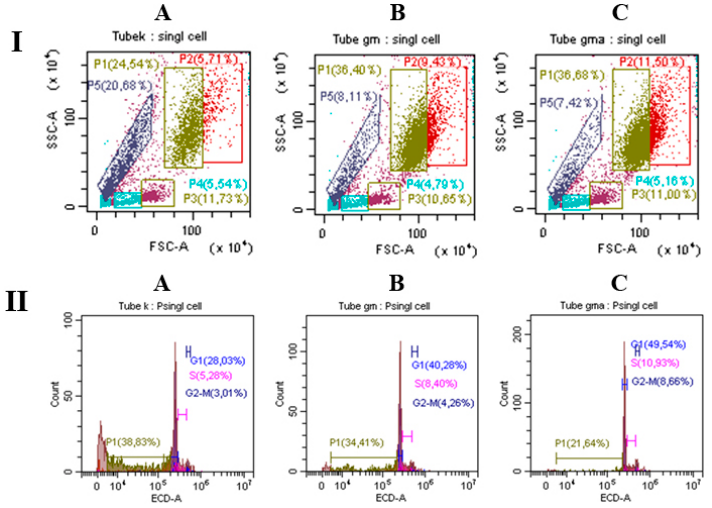
Figure 6. Flow cytometric analysis ( I ) and cell cycle of all BMCs ( II ) treated of ryGM-CSF ( C ) and ryGM-CSF-ApoA-I ( B ) compared to the control after 48 h of incubation ( A ). In percentage terms, the largest difference in the granulocyte lineage of BMC was in the case of ryGM-CSF (36.4% maturing cells, 9.4% dividing cells) and ryGM-CSF-ApoA-I (36.7% maturing cells, /11.5% dividing cells) (Figure 6I). Analysis of the cell cycle